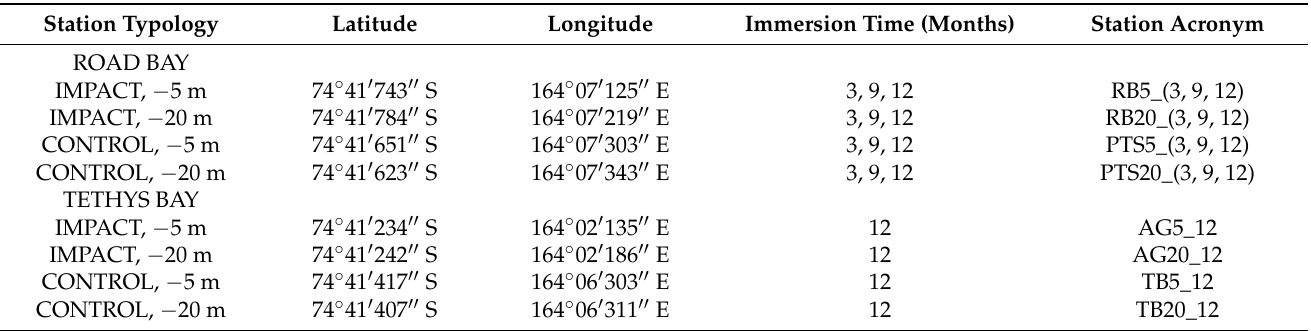
Table 1. Geographical coordinates of the study sites and characteristics of the biofilm samples collected in the Ross Sea (Antarctica).